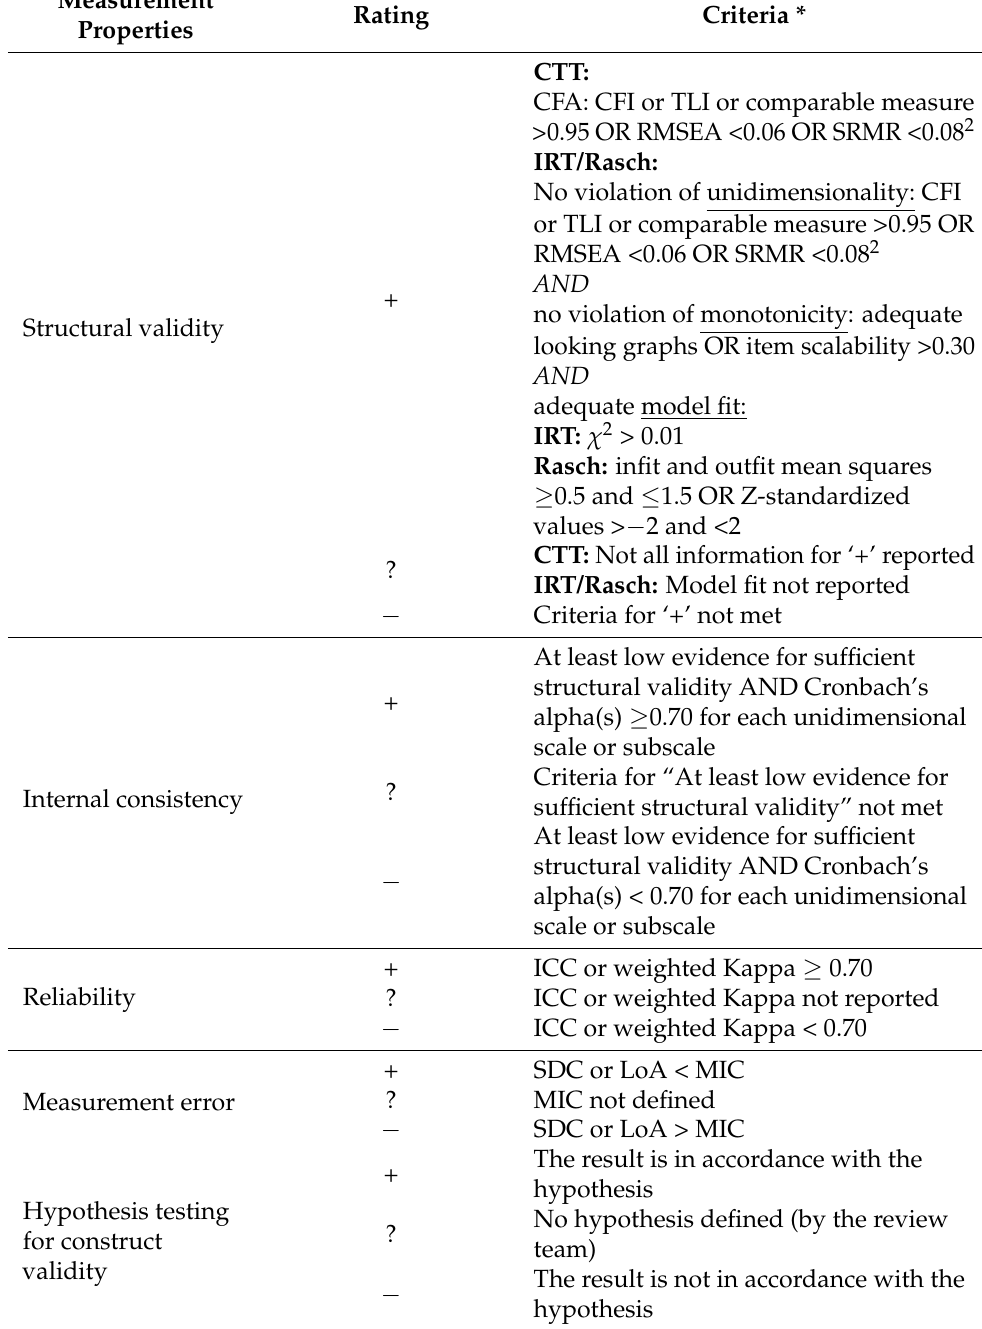
Table 2. Criteria for good measurement